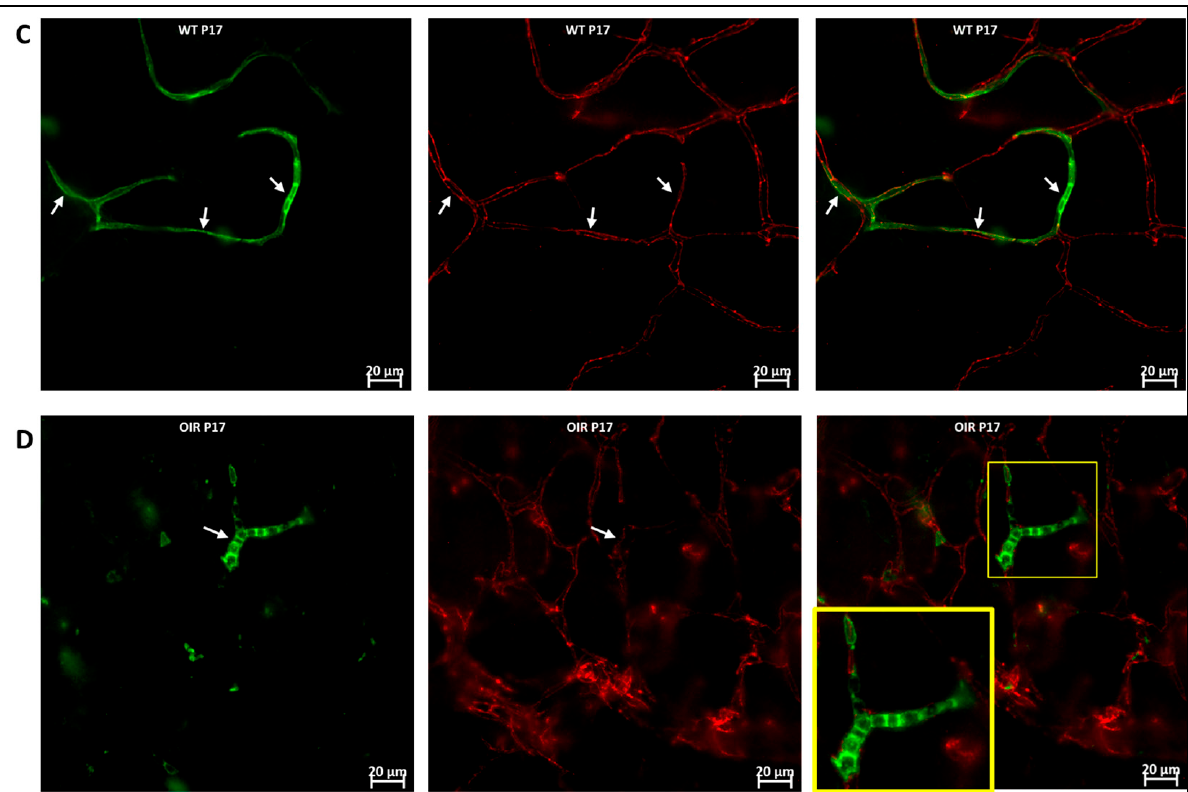
Figure 6. Hematopoietic cells in abnormal vascular development and repair. Representative images ( A , B ) showing retinal flat mounts of Vav1-GFP without OIR ( WT ) and with OIR (OIR) at 3 days (P15; ( A , B )) and 5 days (P17; ( C , D )) post OIR. At P15, GFP + hematopoietic cells are observed forming close association with the vasculature in both models (white arrows). At P17, the peak of neovascularization, recruited GFP + hematopoietic cells are observed to align/aggregate (( D ) , inset) to remodel or repair a damaged vessel in the developing retina.